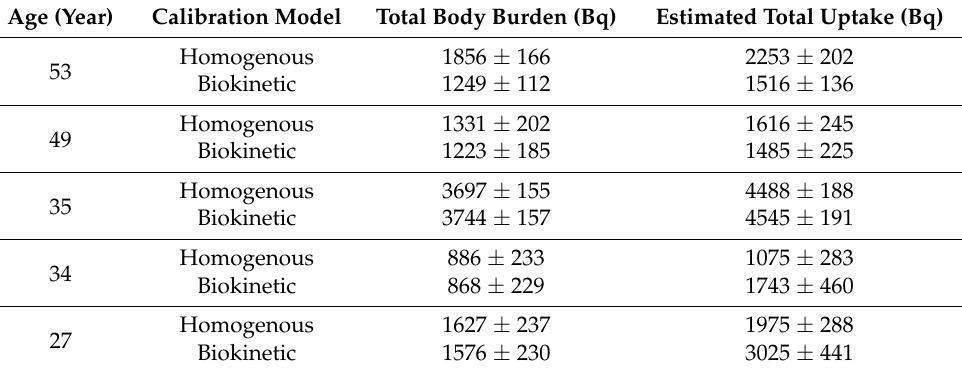
Figure 7. The estimated cumulative iodine changes of the three compartments for the ( a ) 53-year-old and ( b ) 27-year-old men. Table 4. Measurement of total body burden values, and estimated total uptake of 132 Te, derived from the homogenous and the biokinetic calibrations. The total body burden was at 11:30 on 16 March 2011.